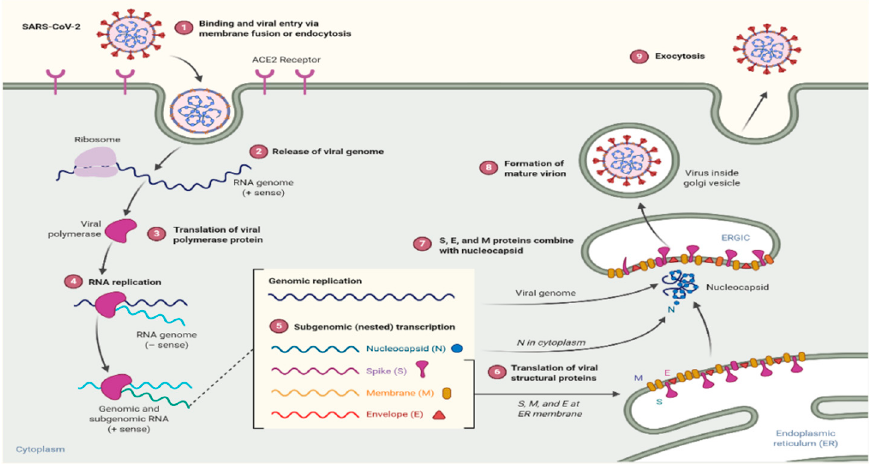
Figure 2. Mechanism of COVID ‐ 19 in the host [40].